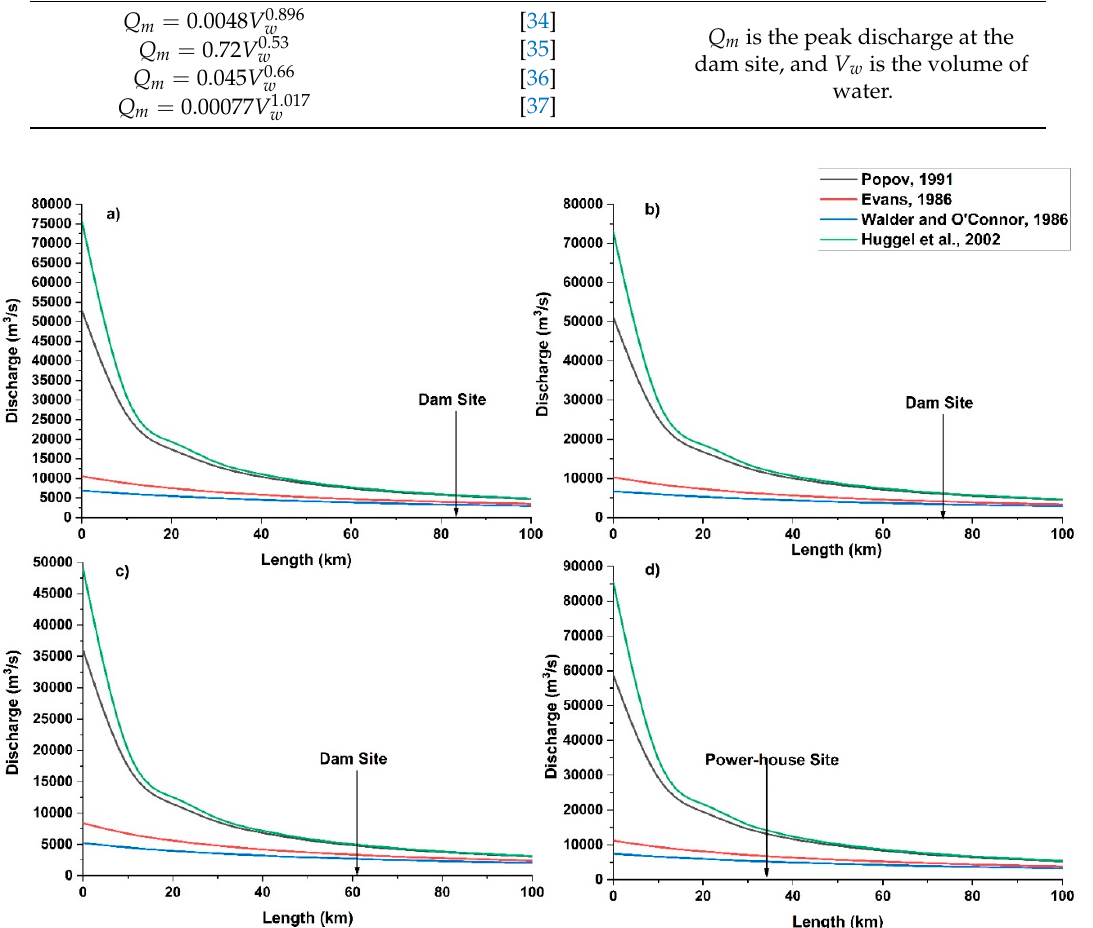
Figure 6. Discharge profiles of lake nos. 20, 35, 36, and 39 in ( a – d ), respectively, from the outburst site to the downstream.